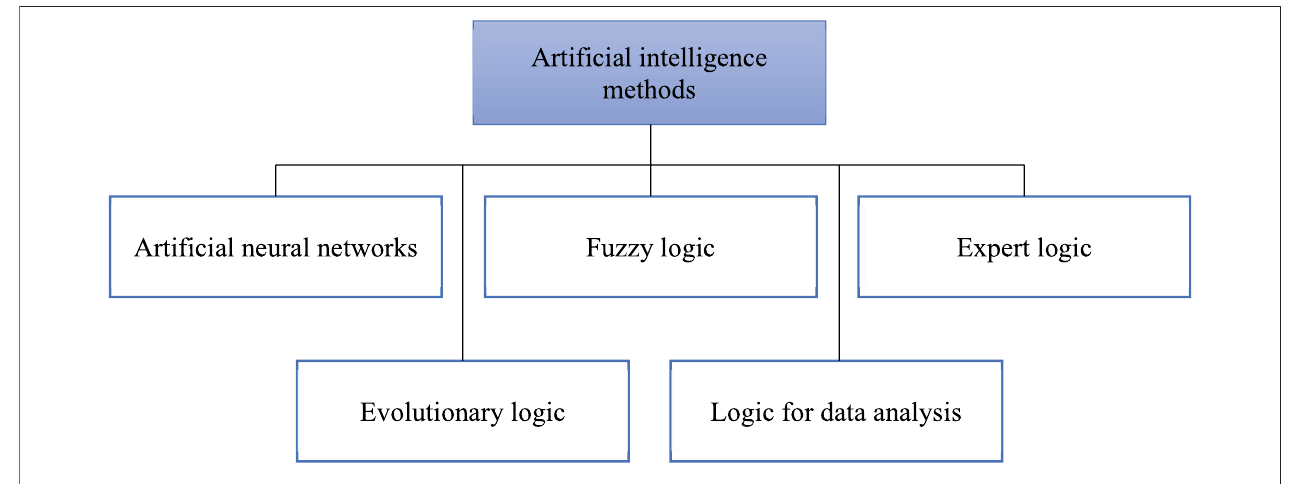
FIGURE 3 | Main groups of AI methods and algorithms (TAdviser, 2020; Codernet,